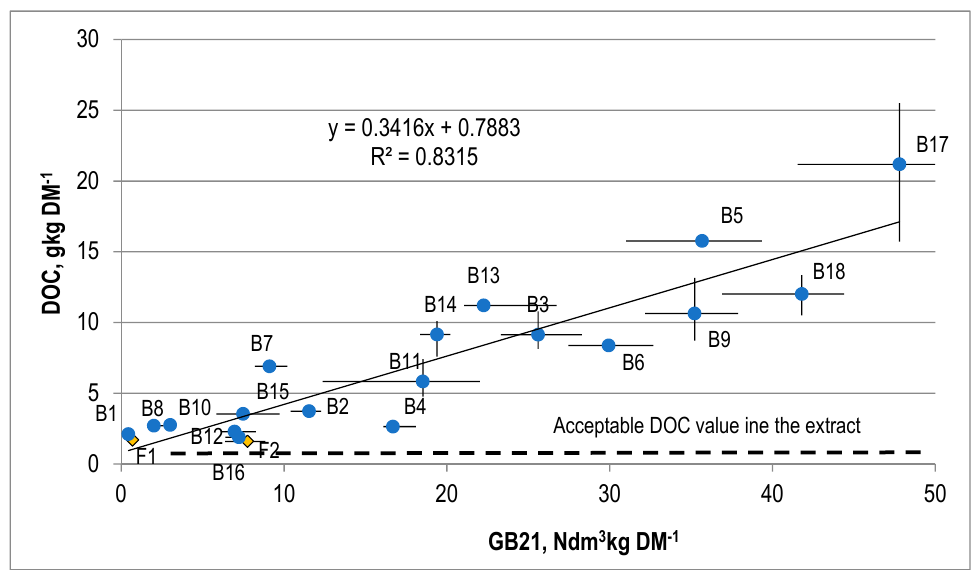
Int. J. Environ. Res. Public Health 2018 , 15 , x Figure 7. The correlation between DOC and AT4 for the stabilized waste. Figure 7. The correlation between DOC and AT4 for the stabilized waste.